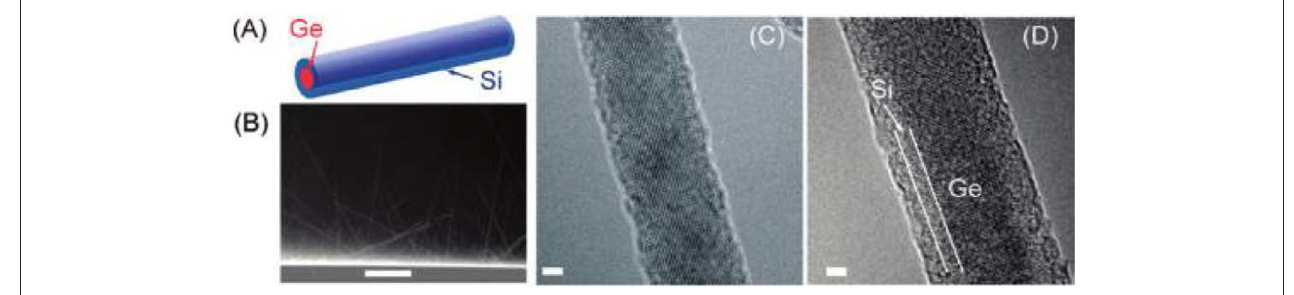
FIGURE 7 | Ge and Ge-Si C-S NWs: (A) Schematic illustration of a Ge-core Si-shell NW. (B) SEM imaging of Ge-Si C-S NWs grown on a Si substrate. (C) High-resolution TEM imaging of a (110)Ge NW. (D) HRTEM imaging of a Ge-Si C-S structure by epitaxially growing the Si shell on the (110)Ge NW. Reprint with permission from Wingert et al. (2011). Copyright 2011 American Chemical